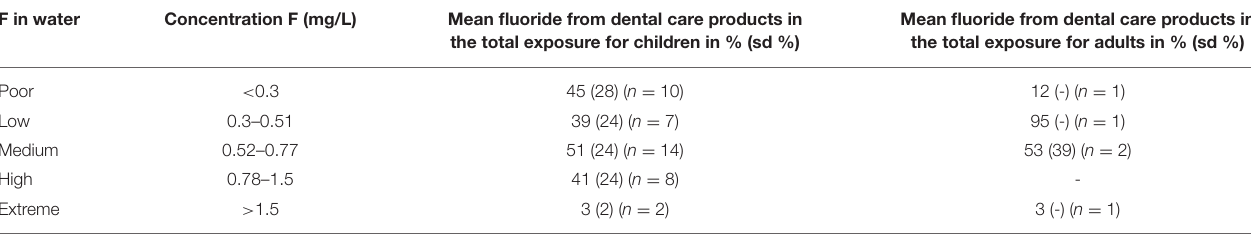
TABLE 3 | Contribution of dental care products in F exposure depending on the F concentration in tap water for children and adults. F in